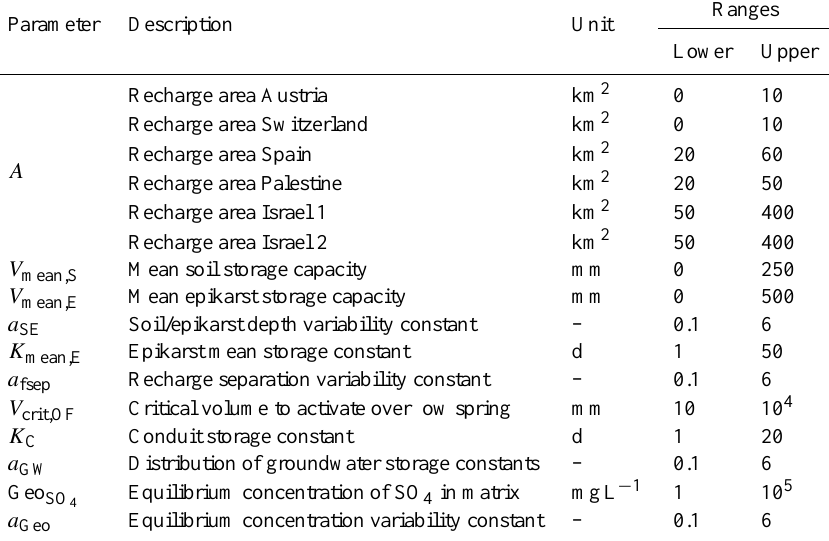
Ranges Lower Upper